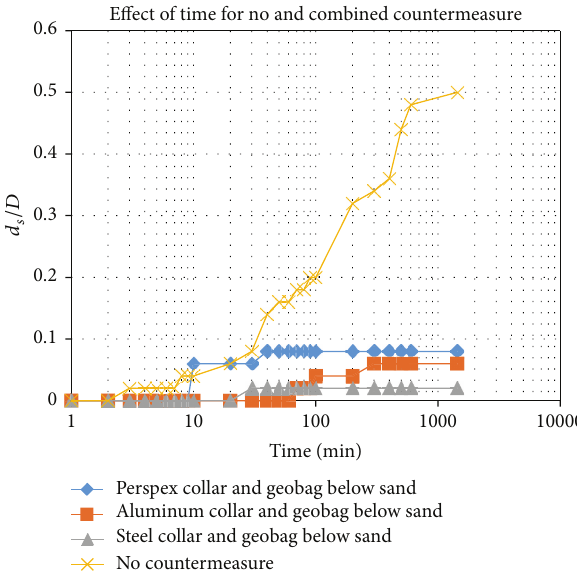
Figure 5: Dimensionless scour depth versus time, for the following scenarios: with combined countermeasure and without counter- measure (Pile 2). Table 2: Percentage of reduction of scour depth at the rear